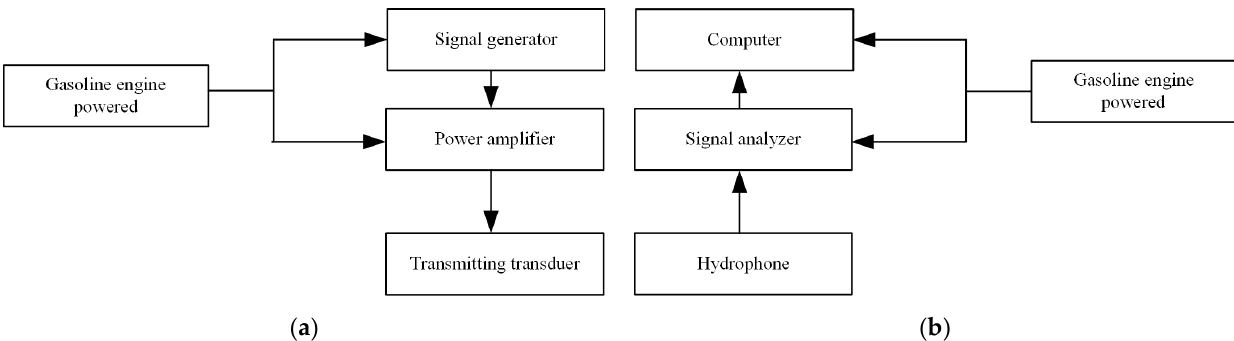
Figure 7. Schematics of experimental equipment: ( a ) transmitting system, ( b ) receiving system.